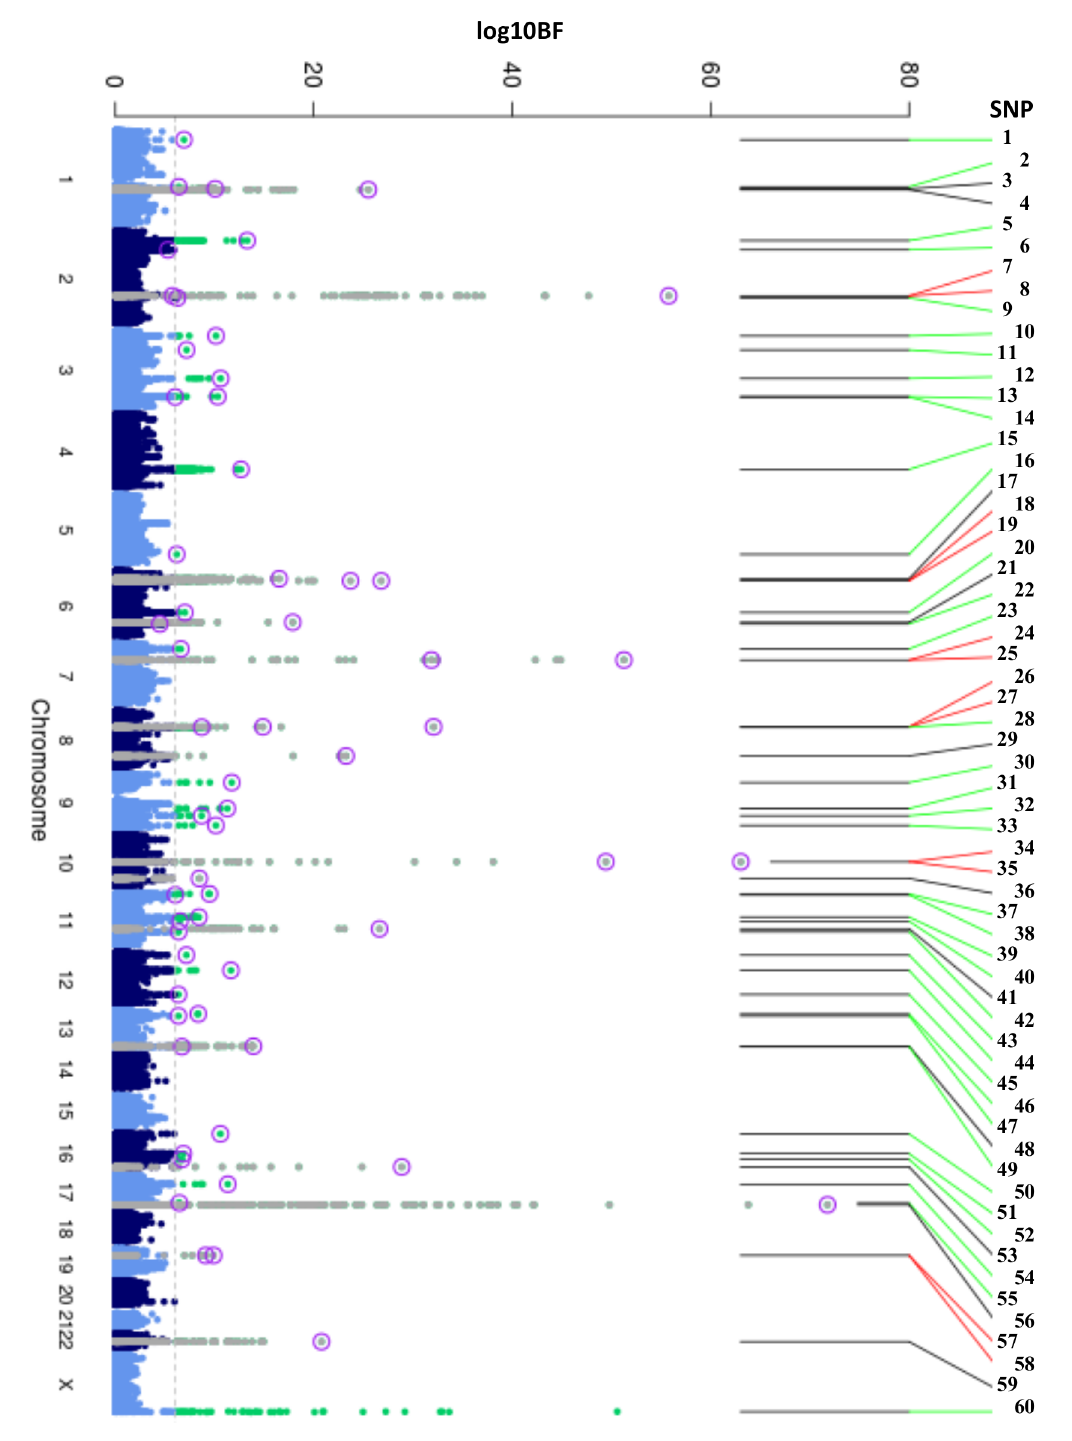
Fig 1. Manhattan plot of HbA1c associated variants. Manhattanplot of the transethnicmeta-analysis results in MANTRA. The dashed grey line indicates log 10 BF = 6. Grey and green points denote known/novel loci, respectively. The lead HbA1c-associated variants identifiedthrough the ancestry-specific/transethnic analysesare circled in purple(the G6PD variant was not includedin the MANTRA analysis, but the locus on the X-chromosome is indicatedin the figure). Lines joiningthe plot & SNP number denote known loci (black), novel loci (green), and loci with a secondarydistinct signal (red). MANTRA, Meta-Analysis of Transethnic Association. https://doi.org/10.1371/journal.pmed.1002383.g001 PLOS Medicine| https://doi.org/10.1371/journal.pmed.1002383 September 12,